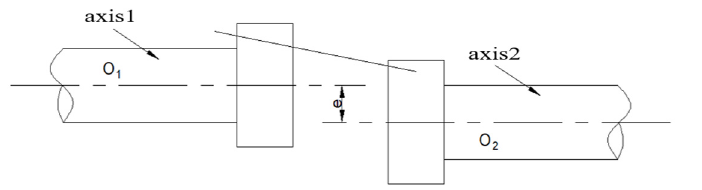
Figure 7. Parallel misalignment.